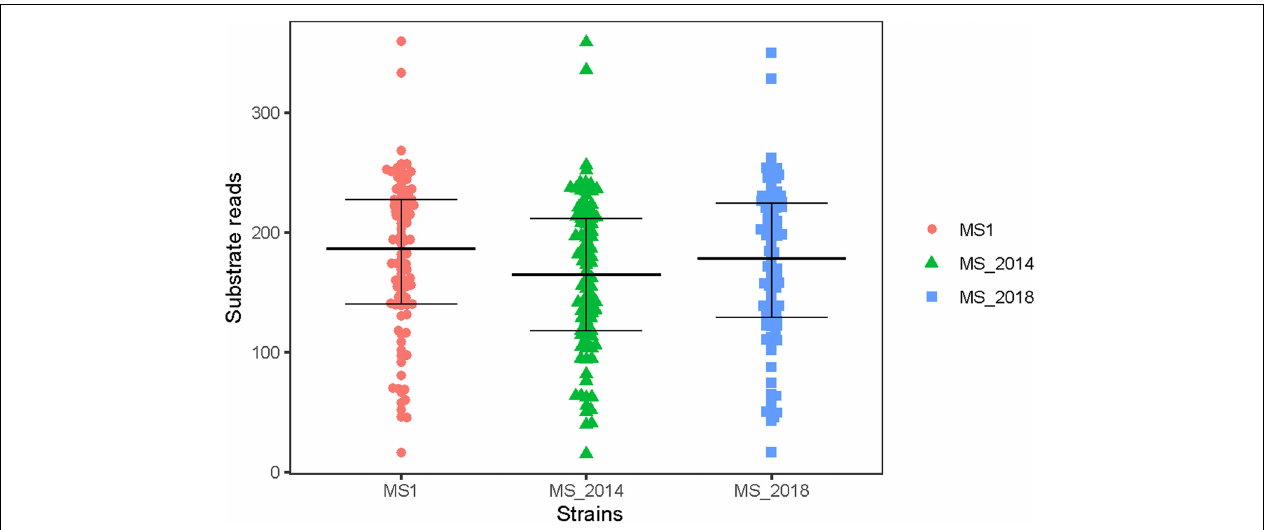
FIGURE 1 | Biochemical characteristics of Dickeya zeae strains from banana using different substrates in BIOLOG analysis. In the BIOLOG assay, the tetrazolium redox dye in the cells induces reduction reaction in the increased respiration of bacteria, and produces purple color. Negative wells remain colorless. The beeswarm presents the original color densities in wells of the utilization assays of 94 substrates, and the bars from below to up indicate the lower quartile, median and upper quartile,